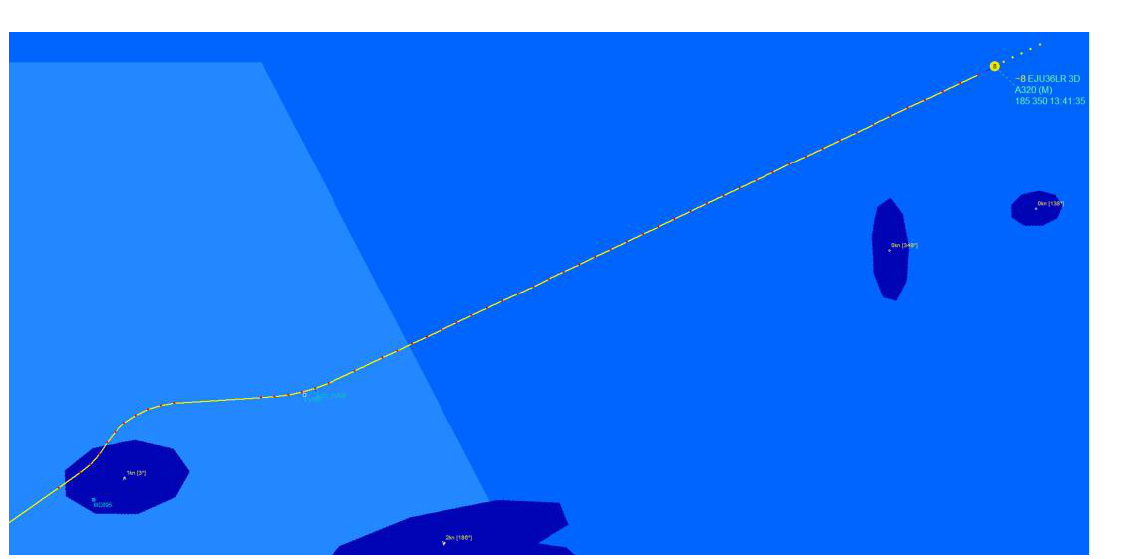
Figure 19. Route calculation for aircraft BEE156H approaching MXP from the northwest through a loose group of convective areas. If several convective cells occur as a group, the AMAN tries to guide aircraft around them as a whole. MXP traffic mix from 11 May 2019 with weather from 6 August 2019 and the RaNDeVIL nowcast model.